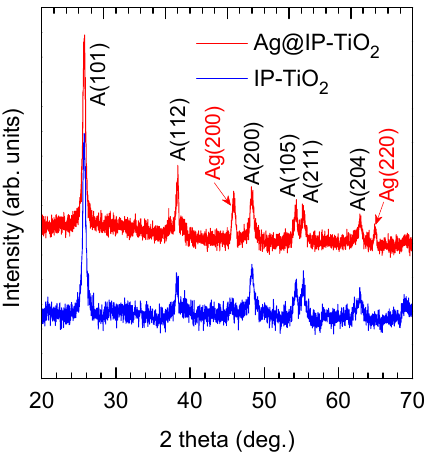
Figure 2. XRD patterns of the IP-TiO 2 ( bottom ) and Ag@IP-TiO 2 nanomaterials ( top ).